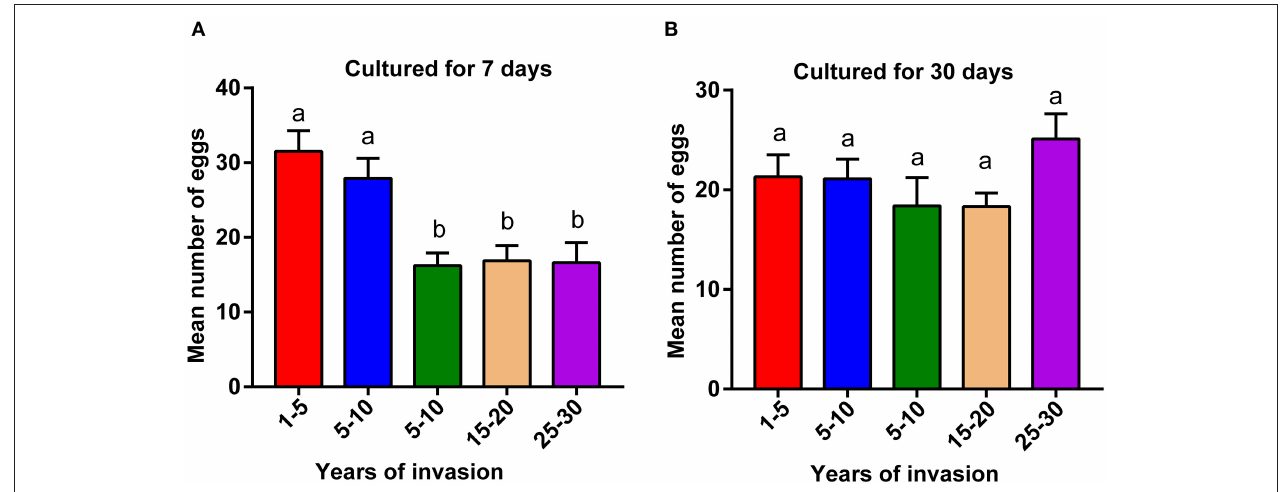
FIGURE 1 | Comparison of pinewood nematode (PWN) fecundity collected from sites differing in the duration of PWN invasion. Fecundity of (A) wild population of PWN cultured in laboratory conditions for 7 days and (B) after the same populations were cultured in laboratory conditions for 30 days. A one-way ANOVA with Tukey’s multiple comparison test, p < 0.05. Data are presented as means ± SEM. Different letters indicate significant differences. The numbers in the x-axis indicate the duration of PWN invasion in years (1–5: 1–5 years of